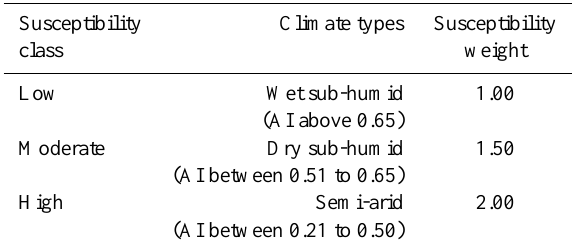
Table 5. Classes and weights of parameters used for climate quality